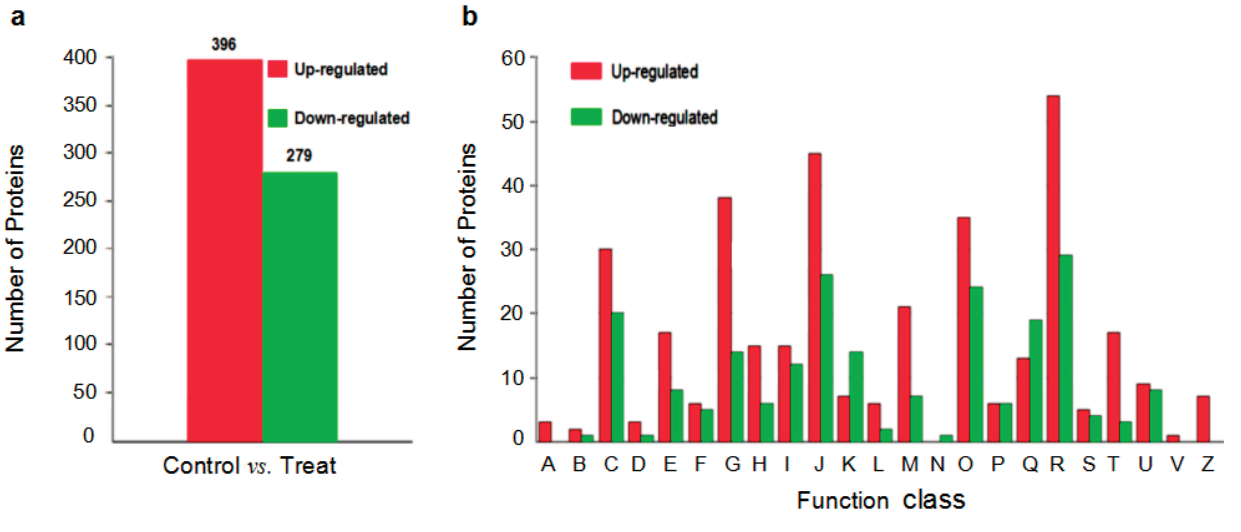
Figure 4. Statistics and COG (Clusters of Orthologous Groups) classification of differentially expressed proteins. ( a , b ) showed the statistics and the COG functional classification of differentially expressed proteins, respectively. A–V and Z represent RNA processing (A), chromatin structure and dynamics (B), energy production and conversion (C), cell cycle, cell division (D), amino acid metabolism and transport (E), nucleotide metabolism and transport (F), carbohydrate metabolism and transport (G), coenzyme metabolism and transport (H), lipid metabolism and transport (I), translation, ribosomal biogenesis and structure (J), transcription (K), DNA replication, recombination and repair (L), cell wall, membrane, and envelope biogenesis (M), cell motility (N), protein modification, turnover, and chaperones (O), inorganic metabolism and transport (P), biosynthesis, transport and catabolism of secondary metabolites (Q), general function prediction only (R), function unknown (S), signal transduction event (T), intracellular trafficking, secretion, and vesicular transport (U), defense responses (V), and cytoskeleton